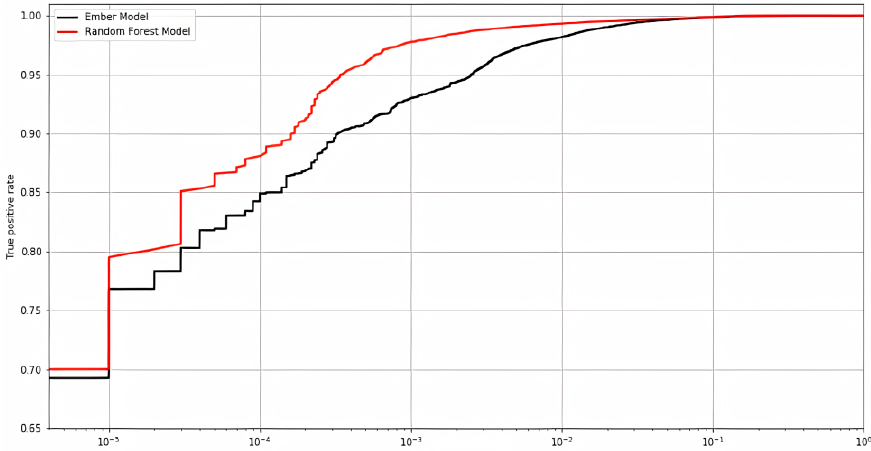
Figure 8. Receiver operating characteristic (ROC) curve of our model, in comparison with the EMBER baseline.